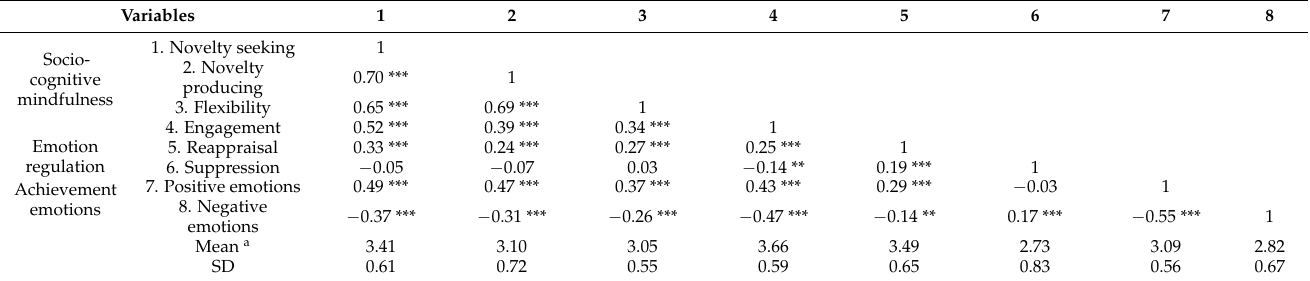
Table 1. Correlations, Means, and Standard Deviations for the Study Variables ( N =